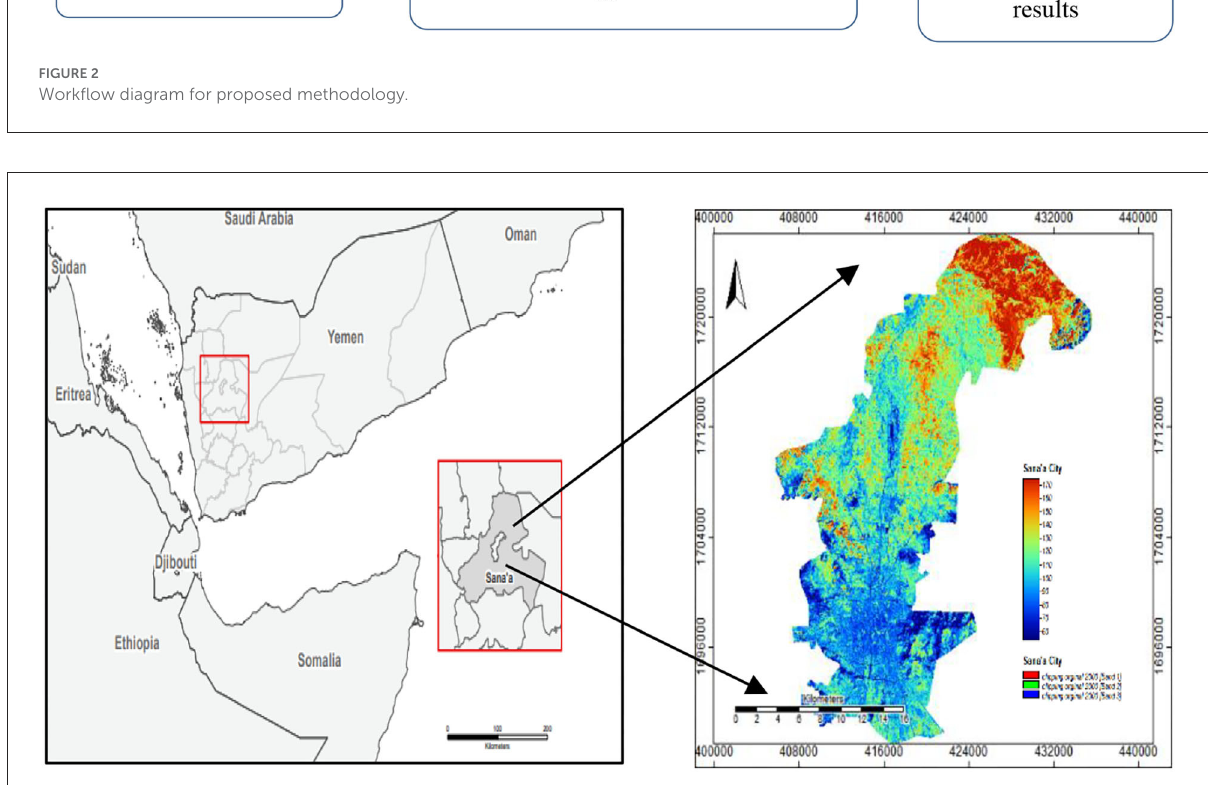
FIGURE3 Location map of the case